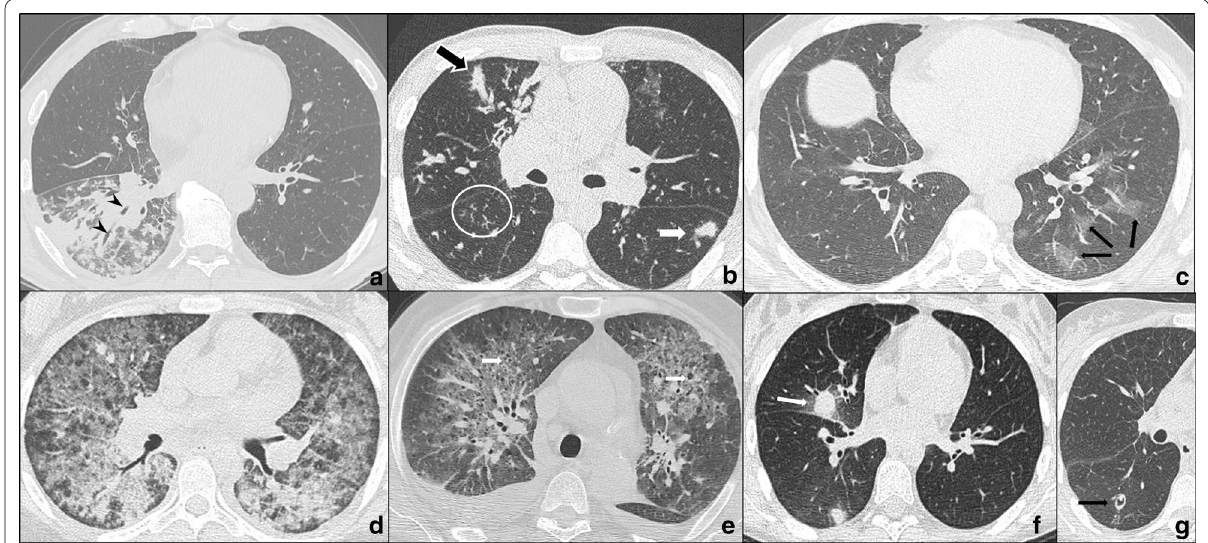
Fig. 2 a – g COVID-19 pneumonia differential diagnosis: infective pneumonia. HRTCs of infective pneumonias. In a , S. Pneumoniae lobar pneumonia shows consolidations with air bronchogram (black arrowheads in a ), while in b , atypical pneumonia presents as multiple nodular (white arrow in b ), tubular (white bordered black arrow in b ) consolidative foci and centrilobular nodules (white circle in b ). In c , HRTC showing centroparenchymal ground-glass opacities (black arrows in c ) in patient affected by Influenza type A pneumonia. Patients affected by HIV and pneumocistis jiroveci pneumonia in d and e , and presenting with bilateral, widespread crazy paving and ground-glass opacities on HRTC during acute pneumonia and perihilar pneumatoceles (white arrows in e ) with pleural effusions in a long-lasting pneumonia. HRCTs of patient affected by angioinvasive aspergillosis at baseline ( f ) and after 7 days ( g ). At baseline, two consolidations rimmed by ground-glass halo are evident in f (white arrow in f , halo sign), while after therapy, excavated nodules showing “air crescent sign” (black arrow in g ) indicate the remission